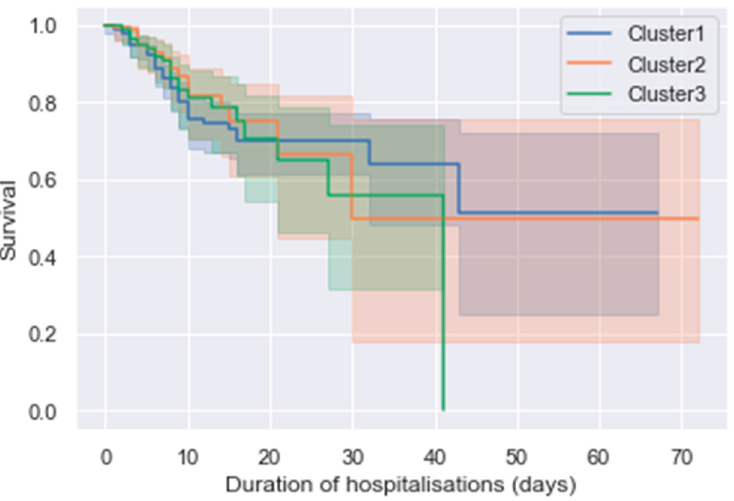
Figure 4. Kaplan–Meier survival curves for the three clusters of heart failure patients. The x -axis shows the duration of hospitalisation in days, and the survival rate is on the y -axis. Patients in cluster 3 (congested cluster) did not survive beyond 42 days, while the survival rate in cluster 1 and 2 is comparable.